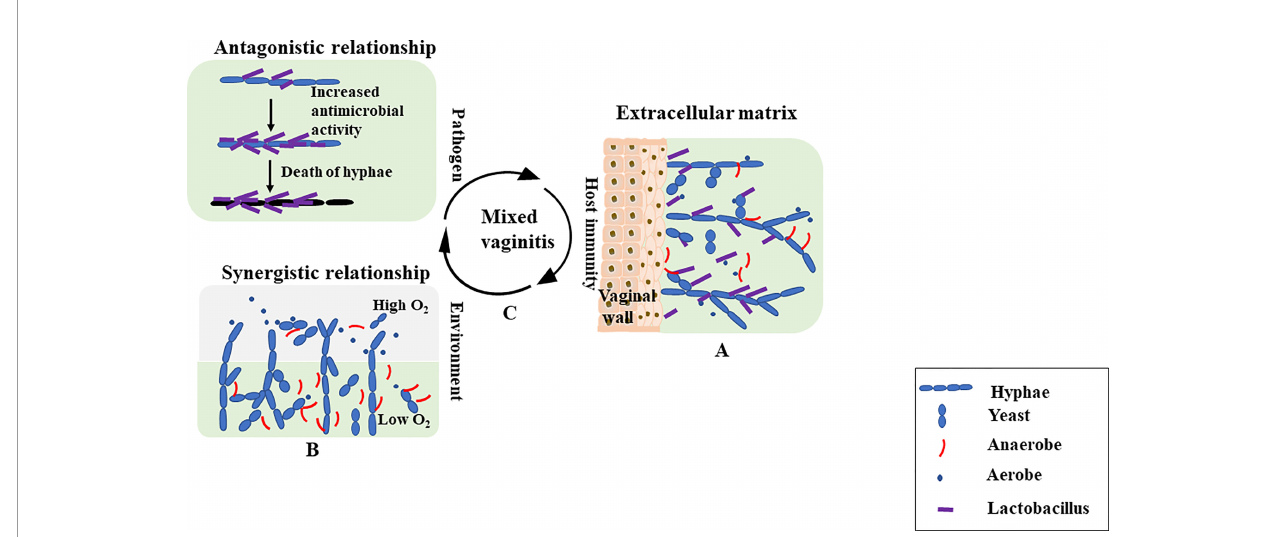
FIGURE 1 | (A) The mixed-bio fi lms are complex structures in which bacteria and/or fungi adhere to the vaginal wall surfaces, and they are encased in an extracellular matrix. The extracellular matrix is a physical barrier to the outside environment. (B) Microbes within the bio fi lm also exhibit antagonistic and synergistic interactions. Lactobacilli can attach to the surface of Candida albicans hyphae . Production of antimicrobials leads to the death of fungal fi laments. In addition to antagonistic interactions, mutually bene fi cial interactions in mixed bio fi lm environments are also possible. For example, C. albicans can protect anaerobic bacteria by providing a low oxygen niche within the depths of the bio fi lm, even though the external environment is aerobic. (C) Antagonistic interactions are more likely to occur between probiotics and pathogens. Synergistic interactions are more likely to occur between pathogens. Different microbes can determine the course of mixed vaginitis. In interspecies interactions, many environmental cues (hypoxia, extracellular pH, body temperature and CO 2 ) and host immune factors could impact the formation of mixed